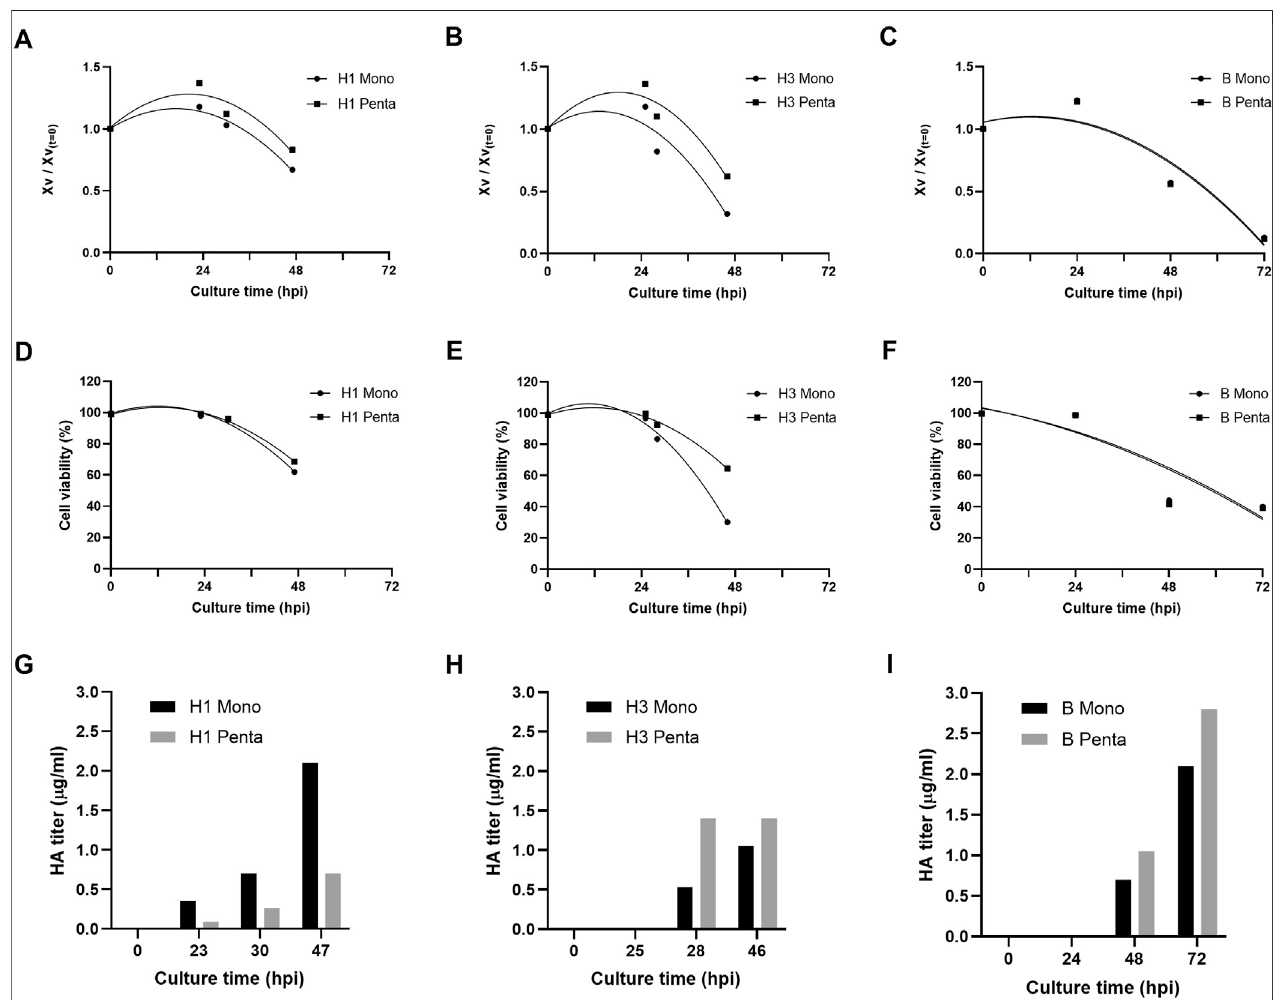
FIGURE 1 | Production of in fl uenza VLPs. (A – C) Normalized viable cell concentration during culture time upon infection, hours post-infection (hpi). (D,E) Cell viability kinetics (%) upon infection (hpi). (G – I) HA titer pro fi le (µg/ml) upon infection (hpi). Data are expressed as a mean of two replicates ( n = 2).